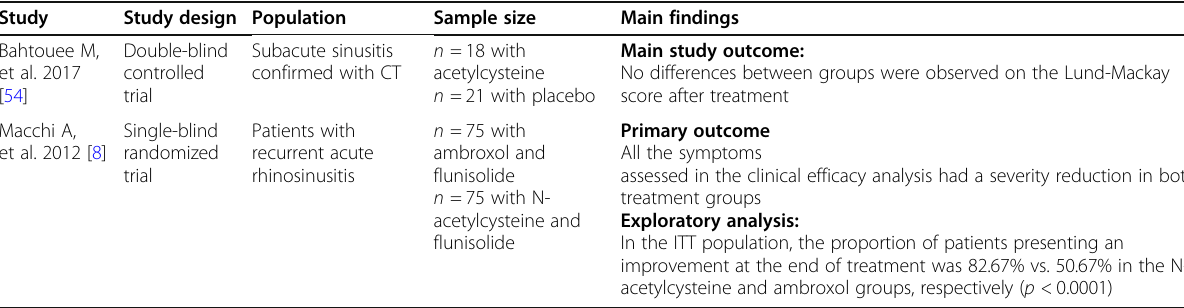
Table 7 Clinical studies of N-acetylcysteine